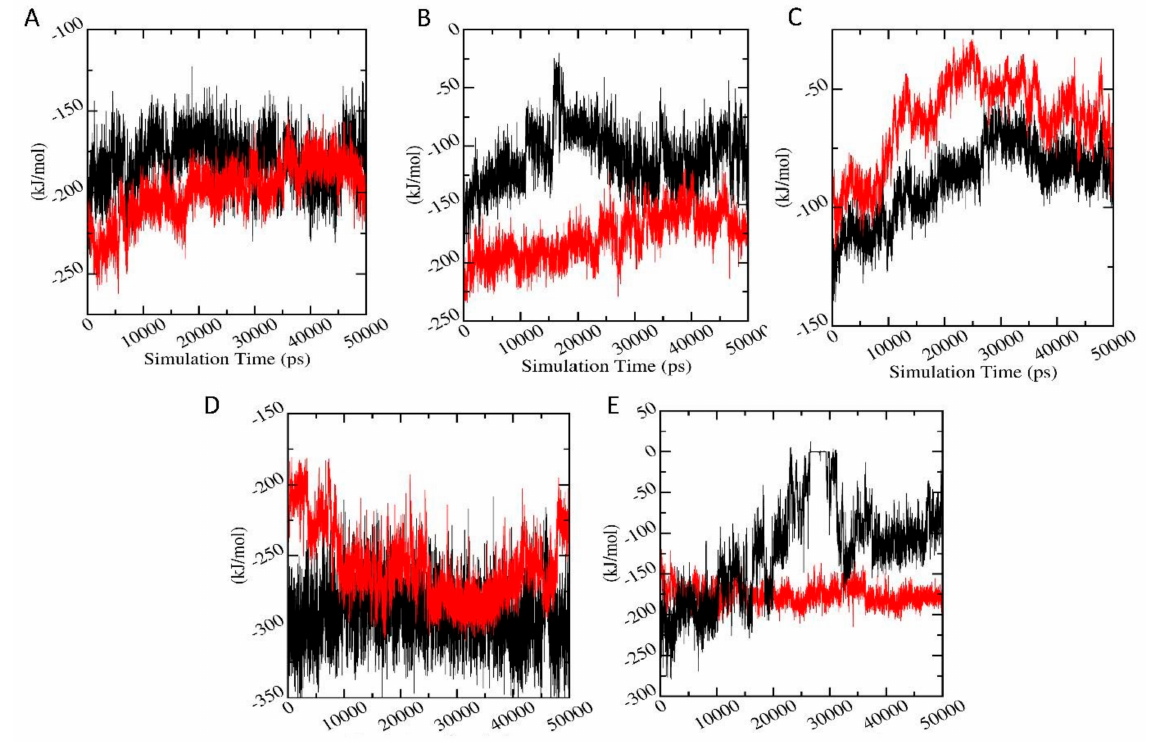
Figure 11. Interaction energy (kJ/mol) versus Simulation time (pS), where black and red color plots represent the parent pesticide and metabolite, respectively. ( A – E ) indicate AChE-FM/FMS, AMPK-FN/FNS, ASK1-FM/FMS, GST-IM/6-CIPHD, and PKC-IM/6-CIPHD complexes, respectively. Table 4. The binding free energy summation of the polar, non-polar energies, and non-bonded interaction energies (Vander Waals and electrostatic interaction) and interaction entropy for protein-ligand complexes.